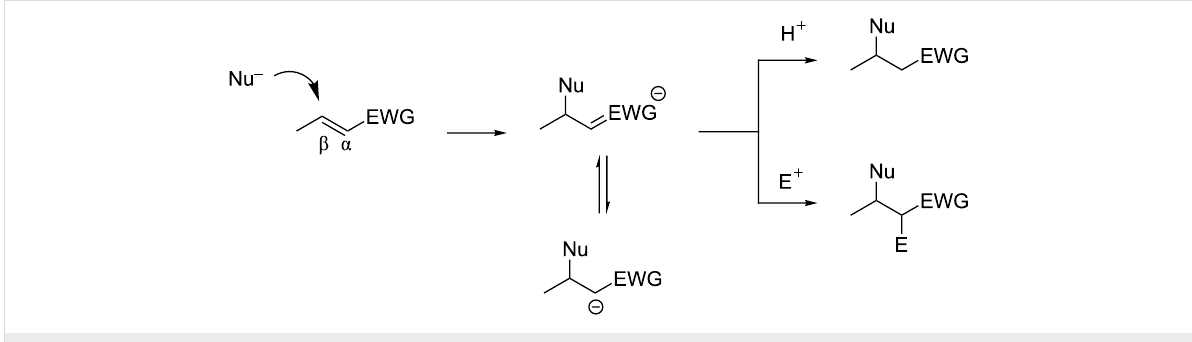
are used as nucleophiles. It has now been well established that “soft” nucleophiles prefer a 1,4-attack whereas “hard” nucleo- philes such as organomagnesium and lithium reagents prefer a